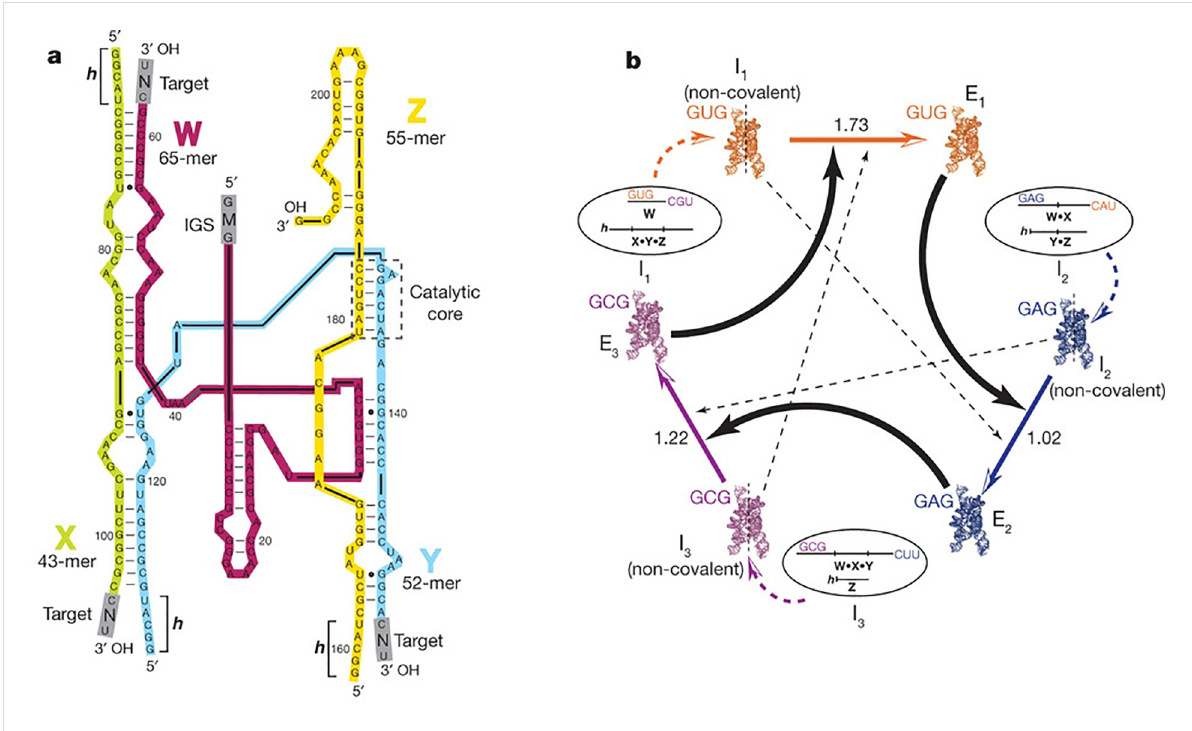
Figure 10: (a) Secondary structure of the Azoarcus ribozyme consisting of four different strands of RNA, W, X, Y, and Z. Self-replication is mediated by recognition of the target sites by the IGS (grey boxes), leading to ligation of the strands. The dashed line indicates the catalytic core of the result- ing ribozyme. (b) Cooperative replicating system. The formation of the covalent ribozyme E3 from the non-covalent I3 complex is catalyzed by E2 ribozyme. The formation of this E2 is in turn catalyzed by E1 , which is catalyzed by E3 , resulting in a cyclic dependence. Numbers above the arrows denote the advantage of cooperativity